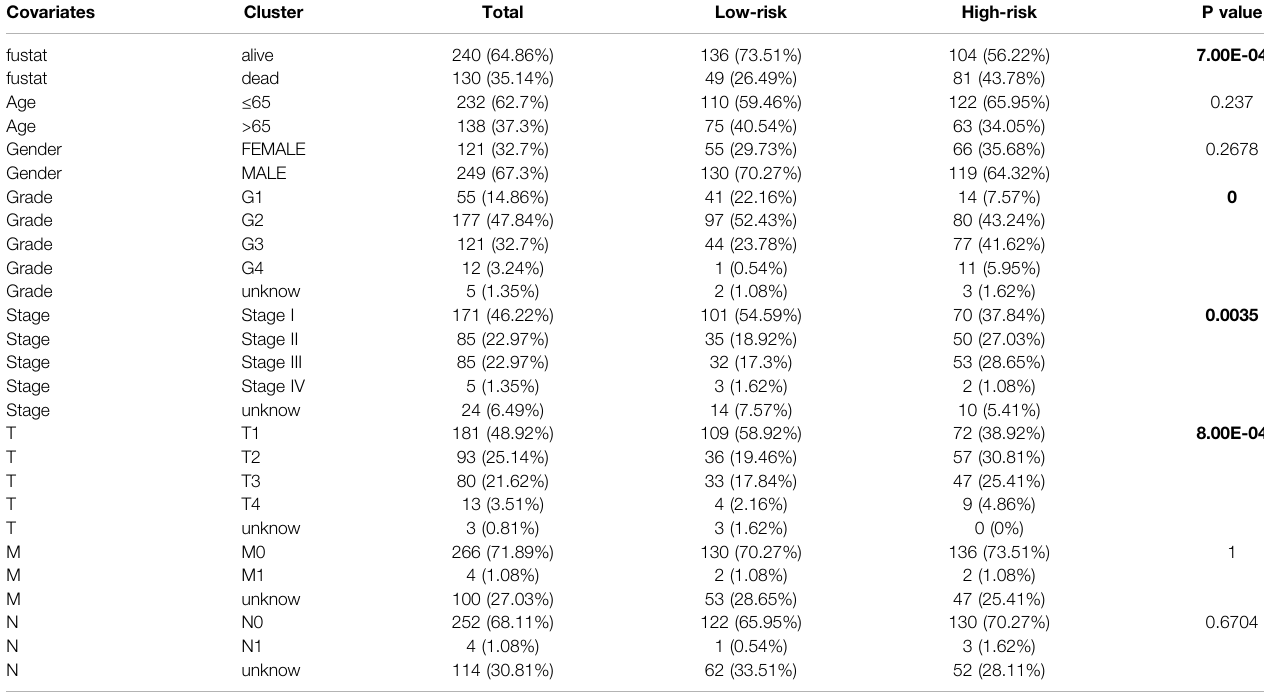
TABLE 1 | Detailed distribution of the number of patients with different clinicopathological characteristics in low- and high-risk groups. Covariates